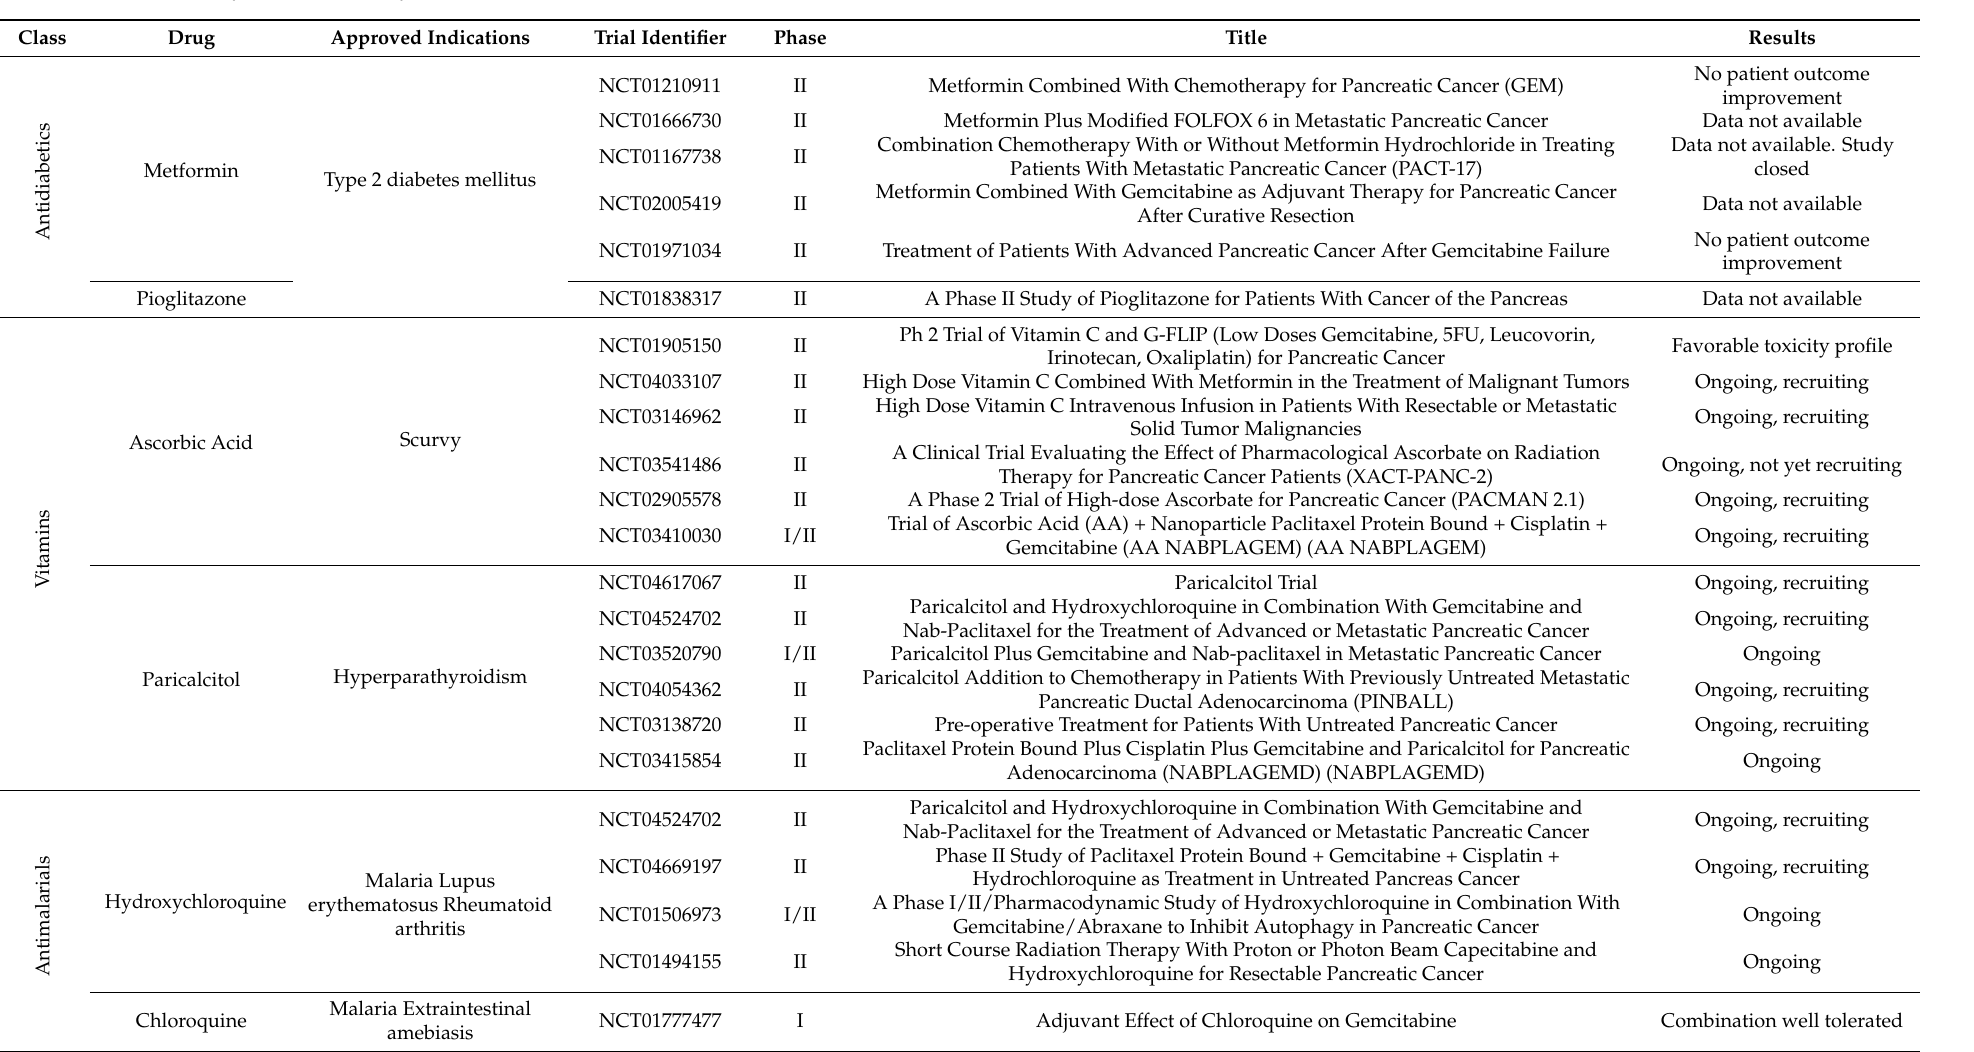
Table 3. Summary of the drug-repurposing clinical trials for pancreatic cancer. The information was searched on the database clinicaltrial.gov (https://www.clinicaltrail.gov, accessed between 3 February and 28 February